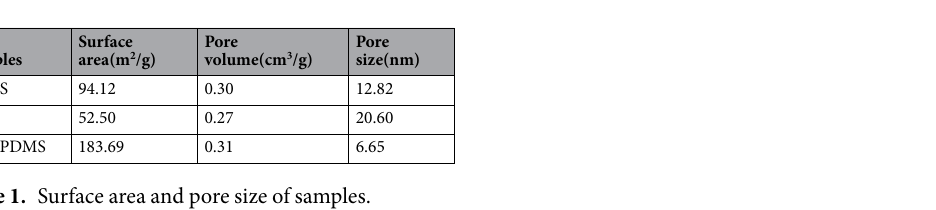
Table 1. Surface area and pore size of samples.